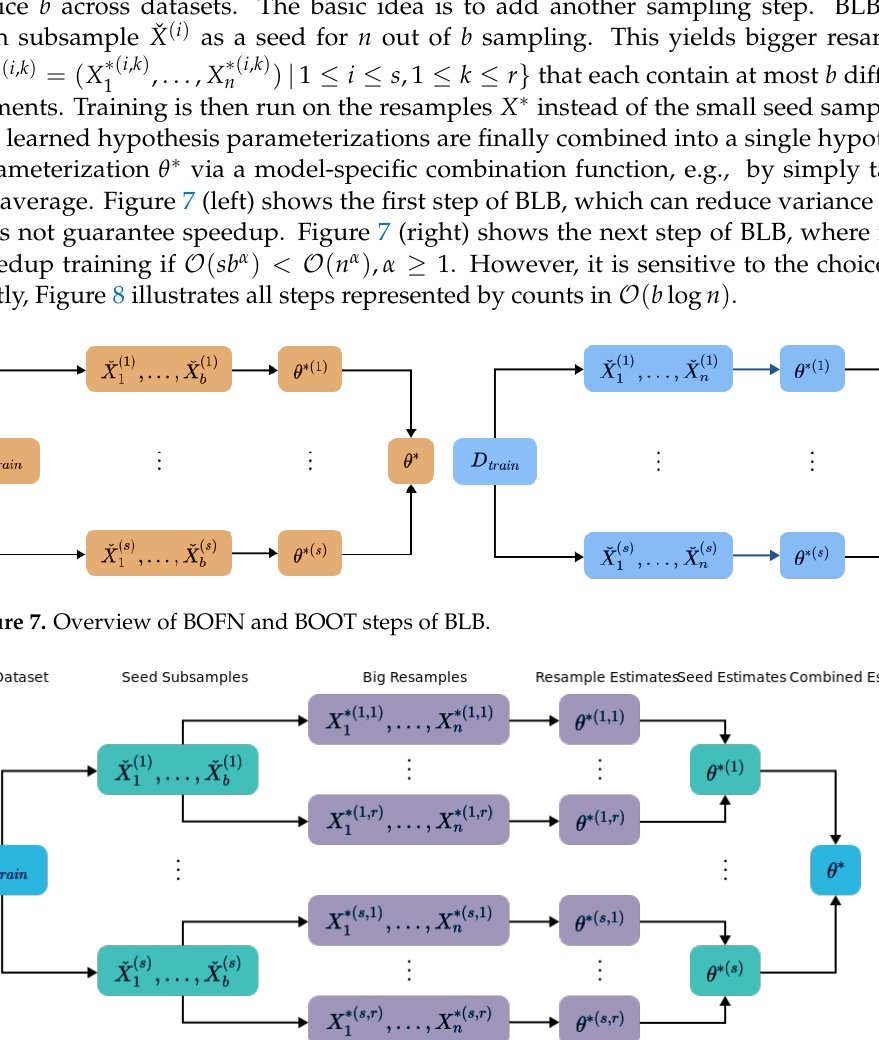
Figure 8. Overview of all steps of